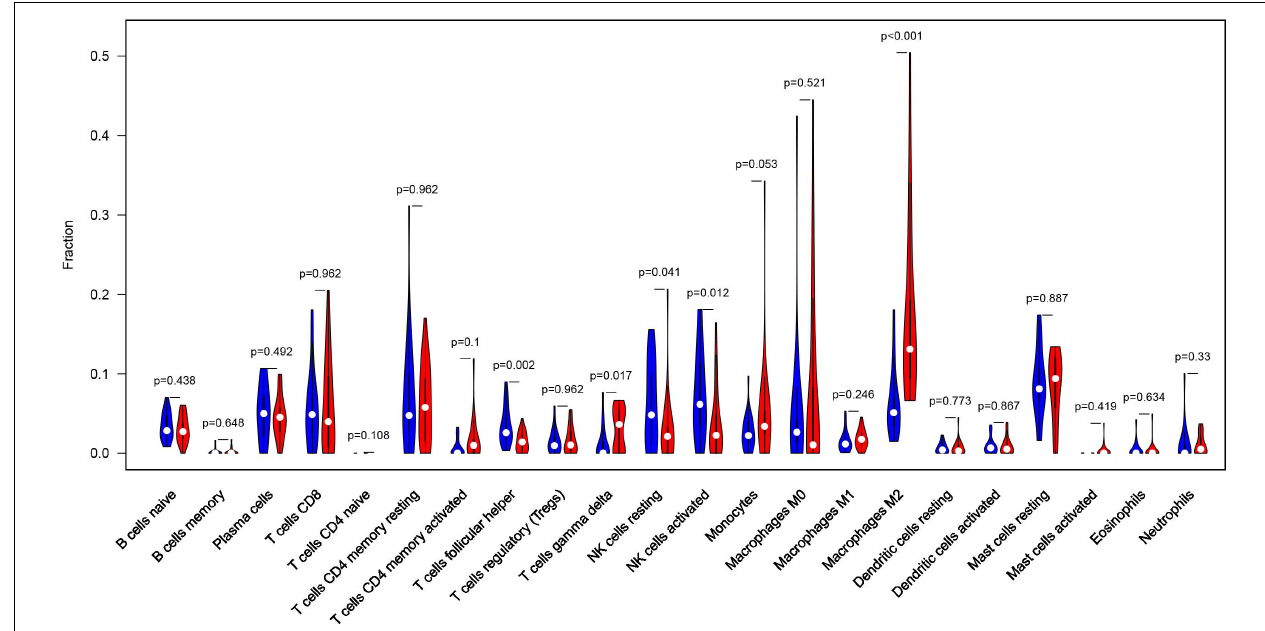
FIGURE 7 | Profile of the level of 22 immune cells’ infiltration in the EM and normal tissues.